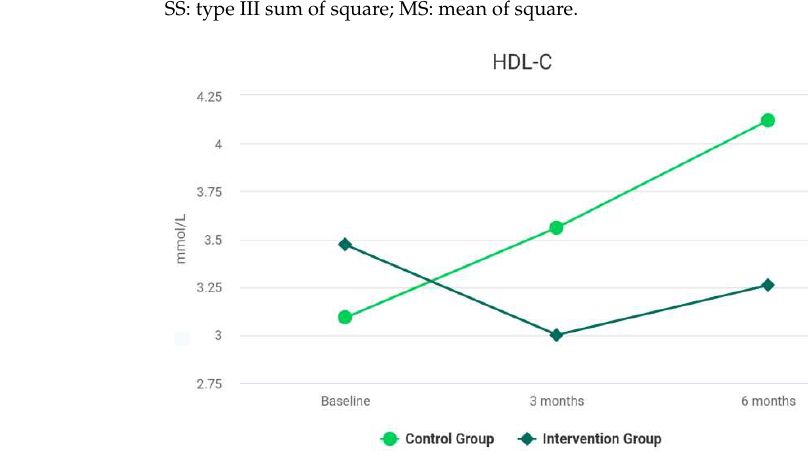
Figure 3. Results of HDL-C at baseline and during Figure 2. Results of HDL-C at baseline and during follow-up.